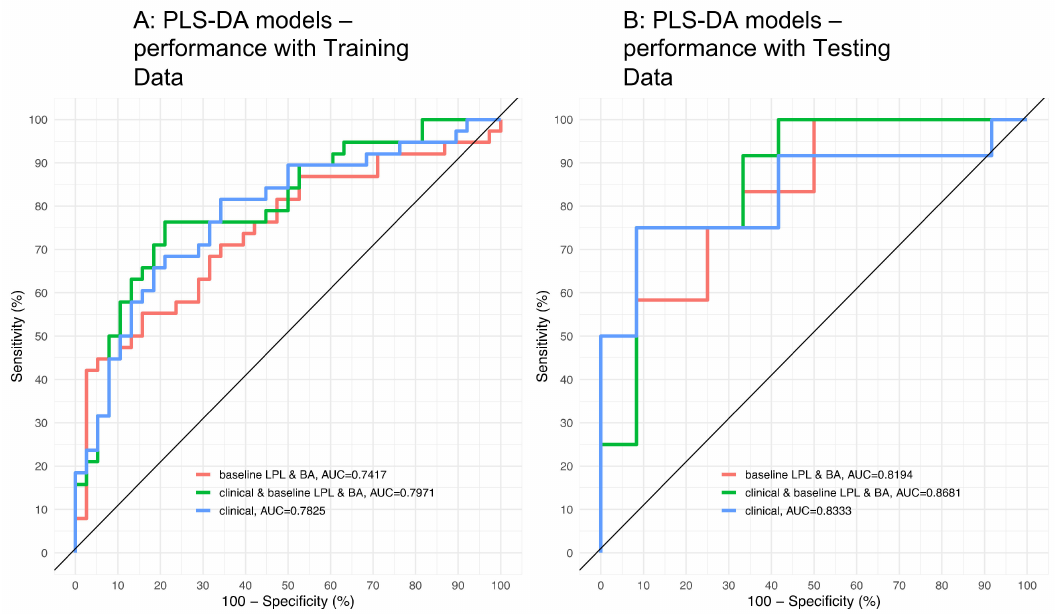
Figure 7. Receiving Operating Curves (ROC) used to predict subjects with high / low homeostasis model assessment of insulin resistance (HOMA-IR): ( A ) Performance for the training set, and ( B ) performance for the testing